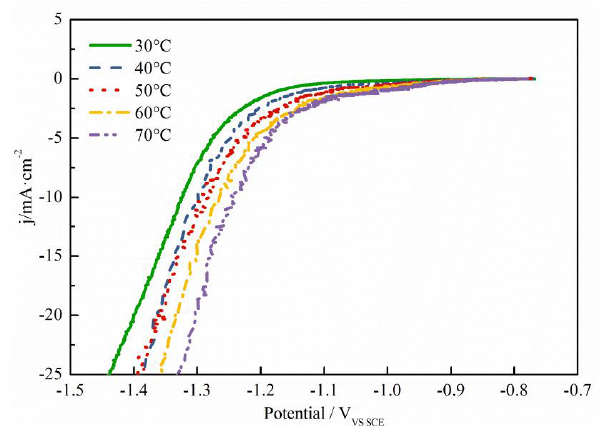
Figure 4. LSV of Co-Mo electrodeposition in electrolytes with different